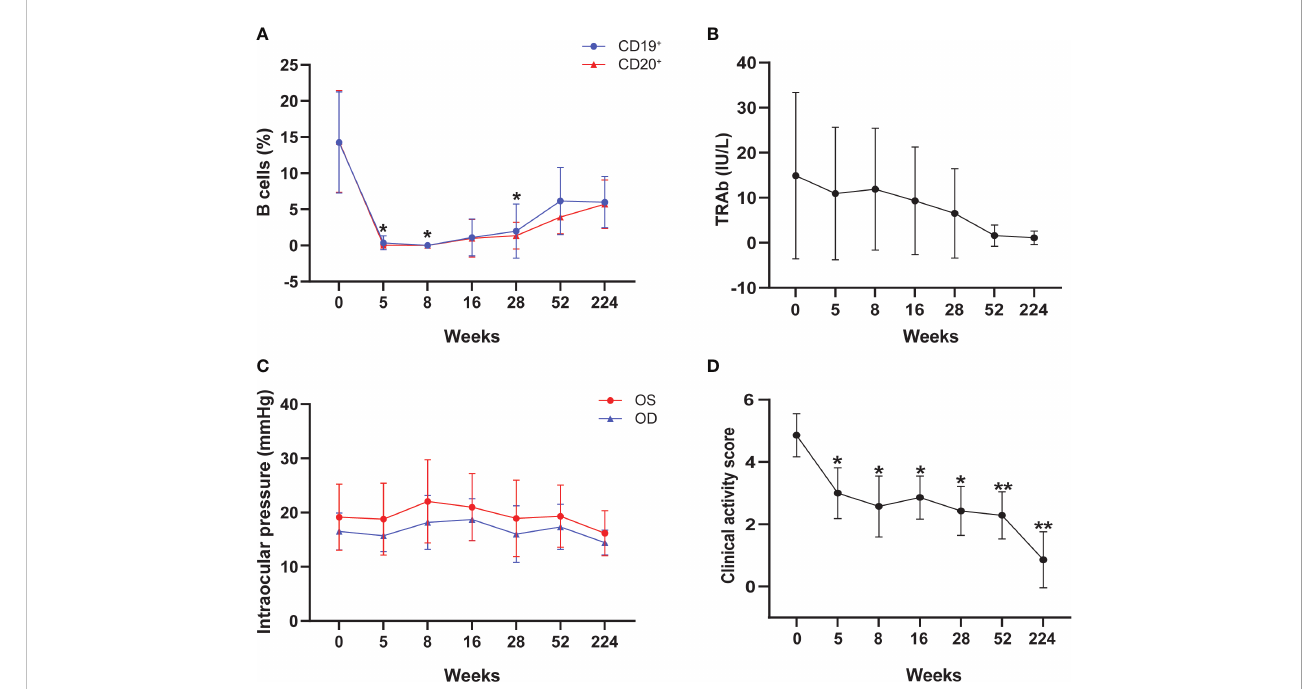
FIGURE 1 Changes of peripheral B cells (A) , TRAb levels (B) , intraocular pressure (C) , and clinical activity score (D) during the treatment of rituximab. TRAb, thyrotropin receptor antibody; The asterisk indicated signi fi cant differences (* P < 0.05, ** P <